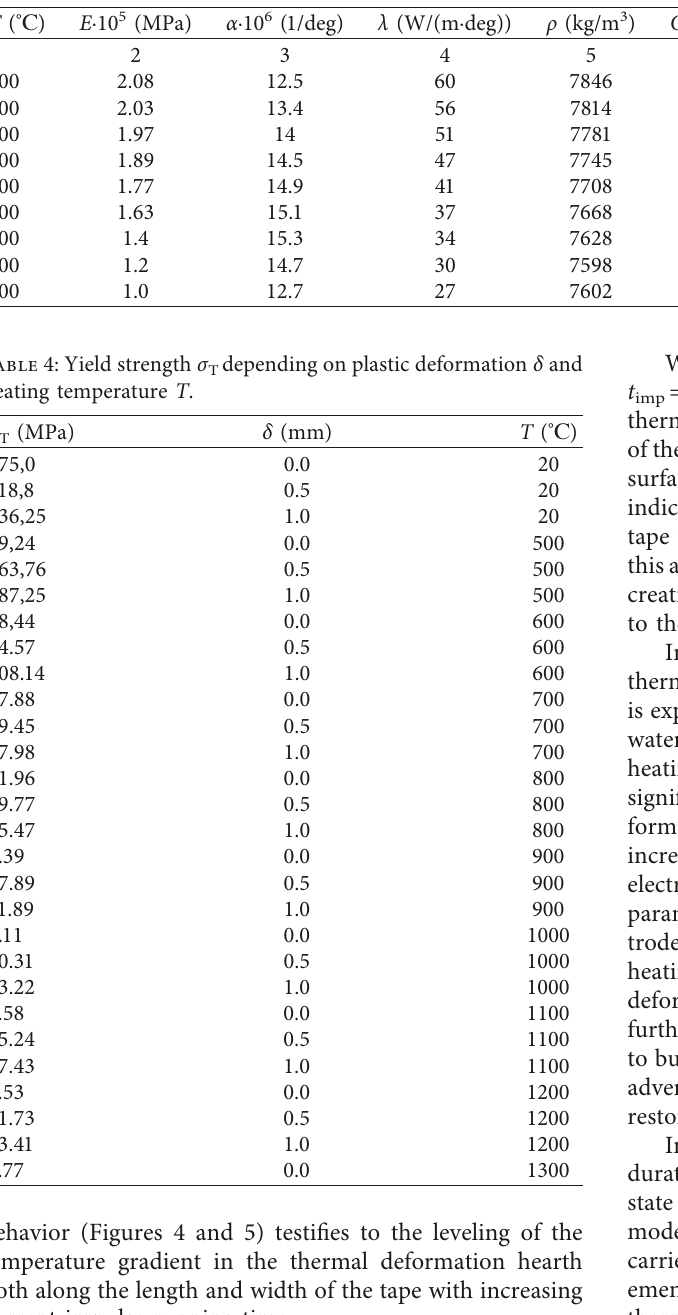
Table 3: Physical properties of the electrode tape depending on the heating temperature.